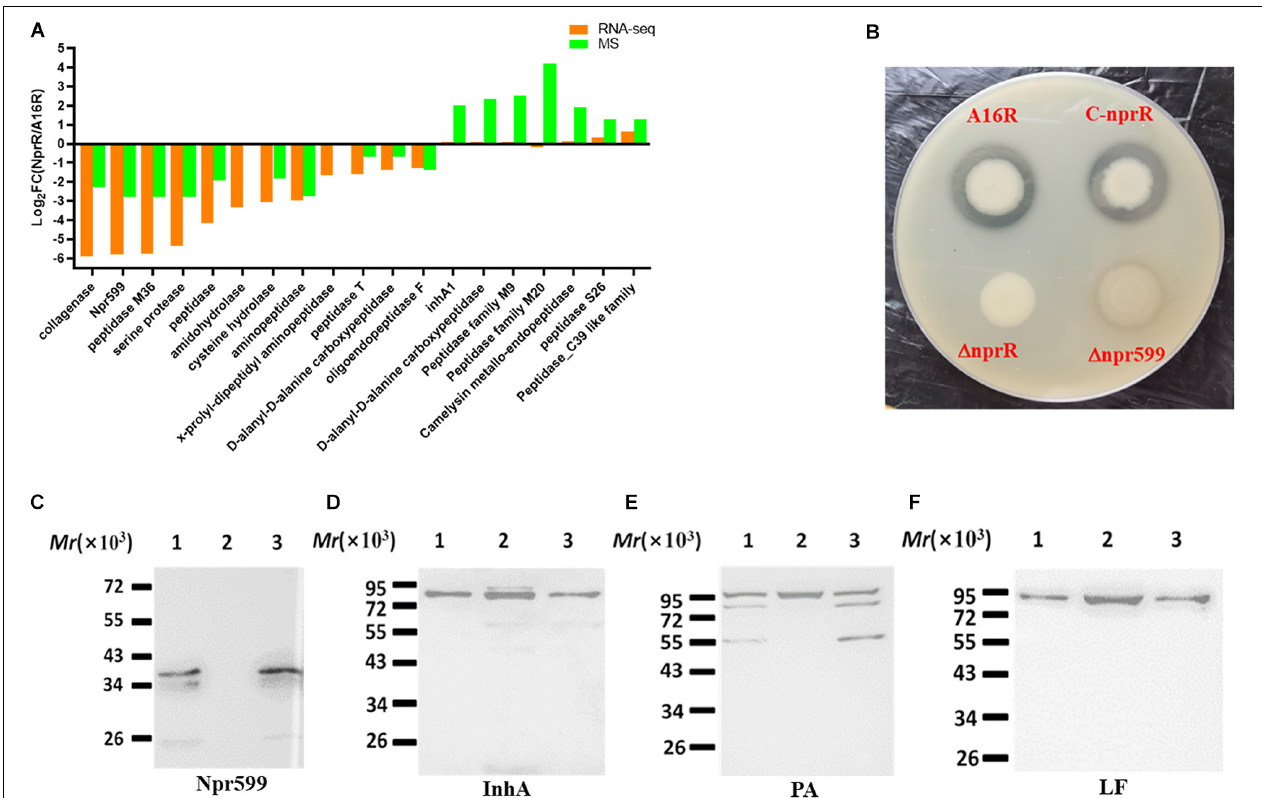
FIGURE 6 | Analysis of protease-related phenotypic characteristics of the nprR deletion mutant. (A) Comparison of protease-related DEGs and DEPs in the nprR deletion mutant strain against the A16R strain. (B) Extracellular proteolytic enzyme activity assays for different strains. Strain colonies with considerable extracellular proteolytic enzyme activity are surrounded by halos. (C–F) Western blot analysis to evaluate the expression of important B. anthracis proteins including Npr599 (C) , InhA (D) , PA (E) , and LF (F) . Lanes are indicated as follows: 1, A16R; 2, the nprR deletion mutant of A16R, 3, the nprR recovered strain. All Western blot experiments were performed at least three